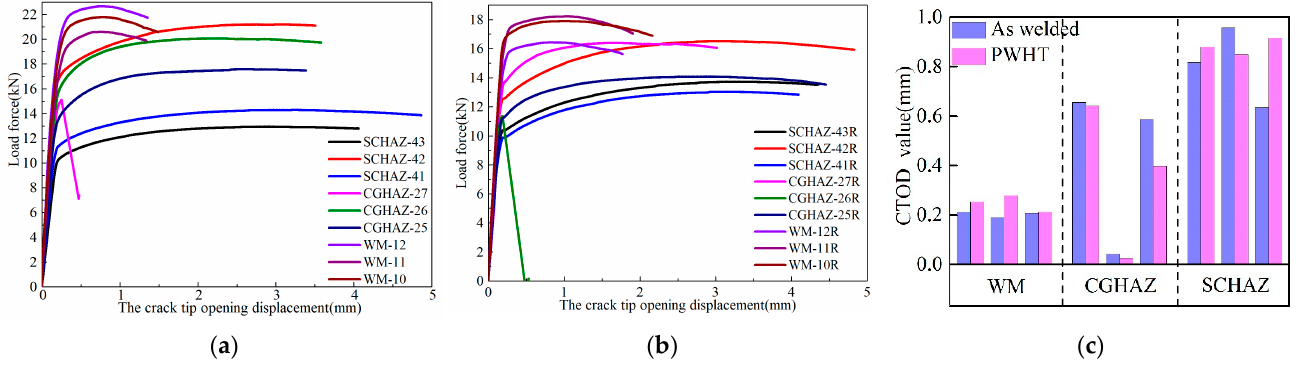
Figure 2. CTOD loading curve and statistical results of characteristic values: ( a ) CTOD loading curve of welded sample; ( b ) CTOD loading curve of PWHT sample; and ( c ) CTOD characteristic value statistics.